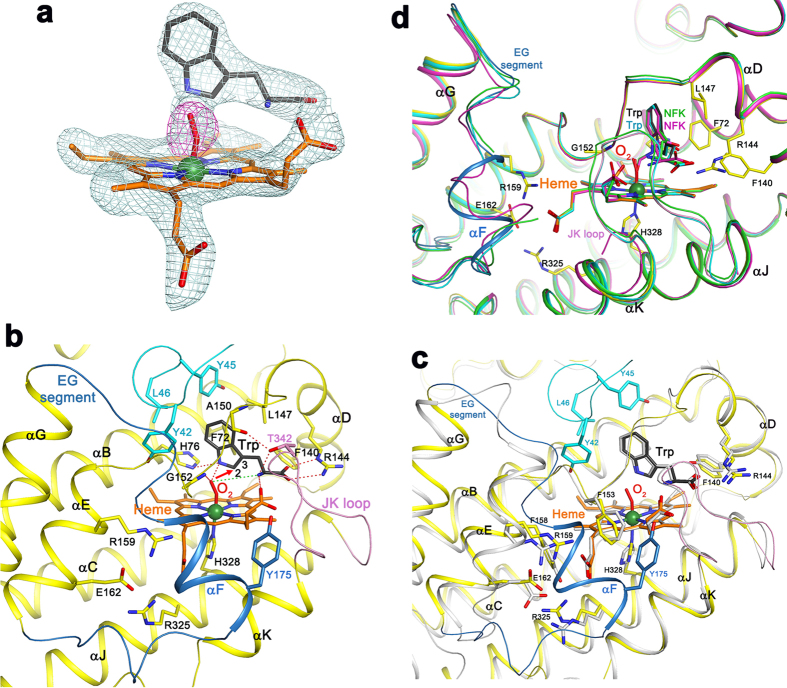
Molecular basis for substrate recognition by hTDO.(a) Omit Fo–Fc map (light blue) at 2.5 Å resolution for heme, L-Trp and O2 in the active site of subunit A, contoured at 3σ. Omit Fo–Fc map for O2 (magenta), contoured at 5σ. (b) Schematic drawing showing the active site of hTDO in the ternary complex with L-Trp and O2. The segment in cyan is from subunit B of the tetramer, which forms a part of the binding pocket for the Trp side chain. The ionic interaction between the terminal oxygen atom and the ammonium ion of L-Trp is indicated by the dashed line in green. The attack of O2 on the C2 atom of L-Trp is indicated with the red arrow. (c) Overlay of the active site structures of hTDO (in color) and XcTDO (in gray). Residues Tyr42, Tyr45 and Leu46 from the N-terminal segment of the neighboring subunit are shown in cyan. (d) Overlay of the active site structures of the four subunits of hTDO. Conformational differences for the EG segment and the disordering the JK loop in two subunits are visible.